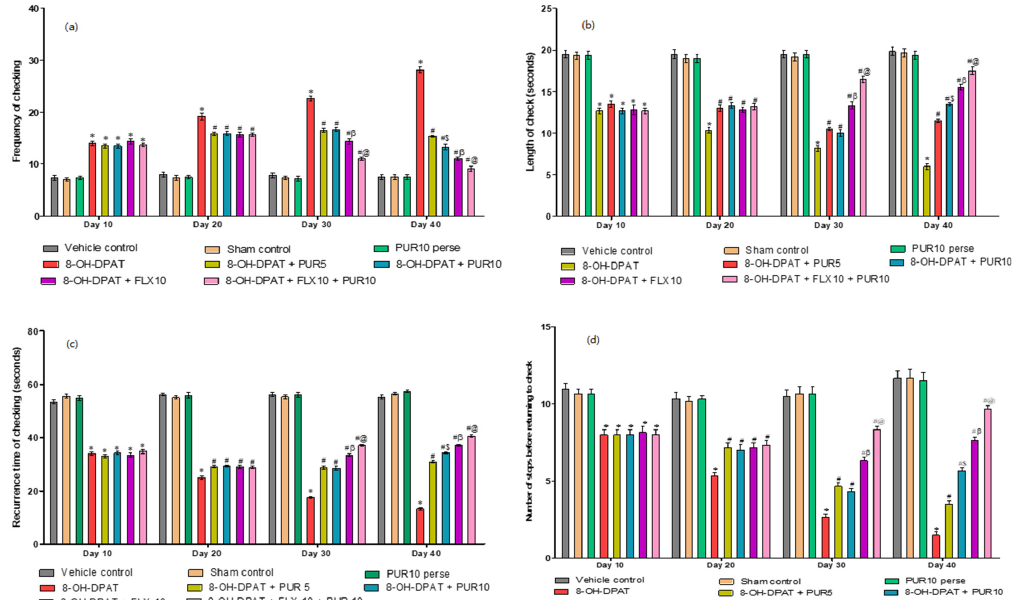
Figure 3. ( a ) Effect of purmorphamine on frequency of checking in 8-OH OCD. Statistical analysis followed by two-way ANOVA (post-hoc Bonferroni’s test). Values expressed as mean ± SEM ( n = 6 rats per group). ( b ) Effect of purmorphamine on length of check in 8-OH OCD. Statistical analysis followed by two-way ANOVA (post-hoc Bonferroni’s test). ( c ) Effect of purmorphamine on